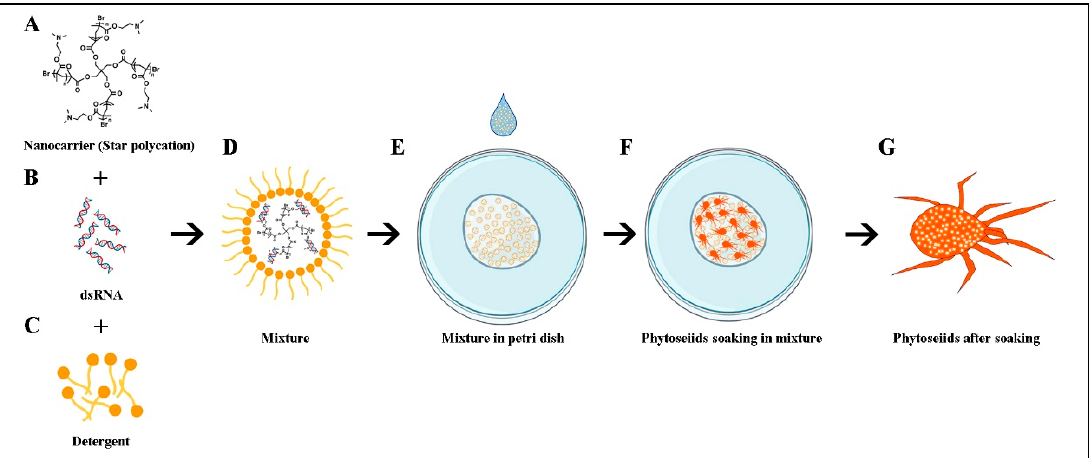
Figure 1. Process of nanocarrier SPc mediated dsRNA delivering through soaking. ( A ) Nanocarrier SPc; ( B ) dsRNA; ( C ) detergent tween 20; ( D ) formulation of SPc, dsRNA and detergent; and ( E–G ) soaking